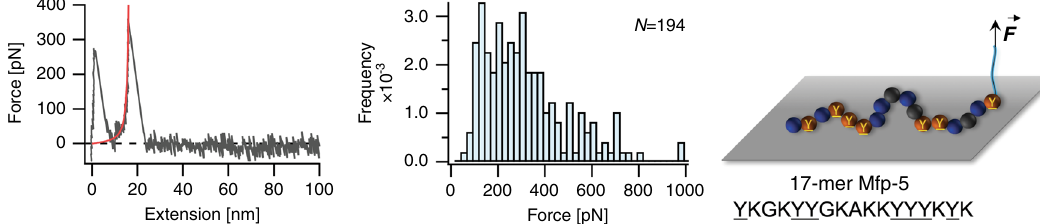
Fig. 5 SMFS results for interaction of 17-mer Mfp-5 peptide with the TiO 2 . Representative F – X curve, rupture force distribution, and schematic of the peptide interacting with the substrate are shown from left to right, respectively. N value represents the total number of rupture events used to plot the histogram. Source data are provided as a Source data fi